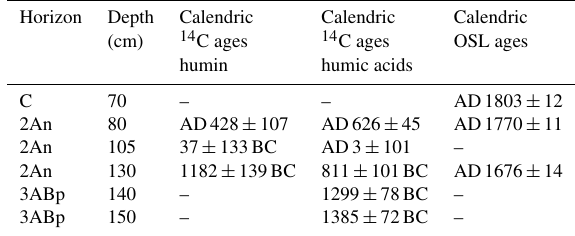
Table 2. 14 C and OSL dates of the plaggic deposits of